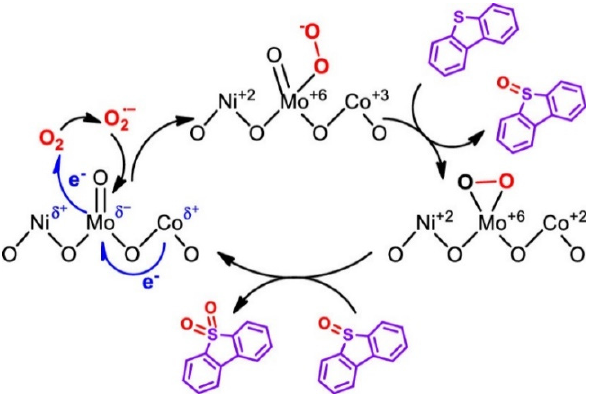
Figure 1. Proposed Catalytic Mechanism of Aerobic Oxidation of DBT Over CoNiMo Catalysts [67].